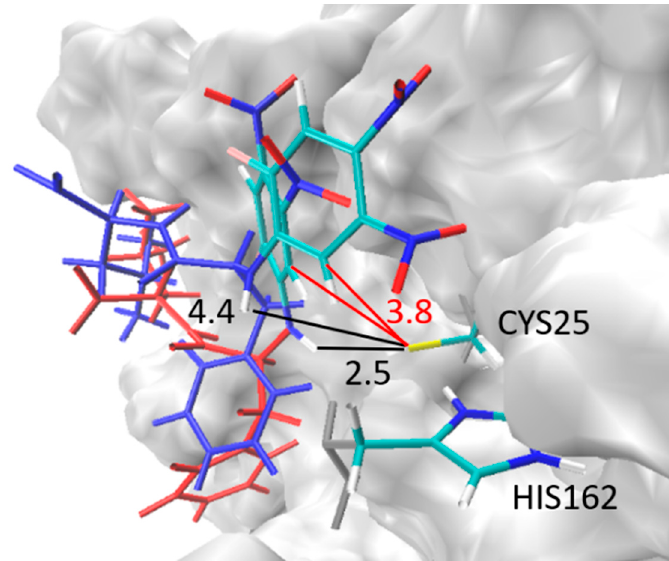
Figure 10. Charts ( a ) and ( b ) present the fluctuation of the distances between the sulfur center of Cys- 25 and the carbon centers (CX) of the aromatic ring: ( a ) = distance S … CH; ( b ) = S … CNO 2 . ( c,d ) give the fluctuation in the distance of the Cys-S … H-N hydrogen bond along MD 5 ( c ) and MD 6 ( d ). All simulations start from the pose in Figure 9.